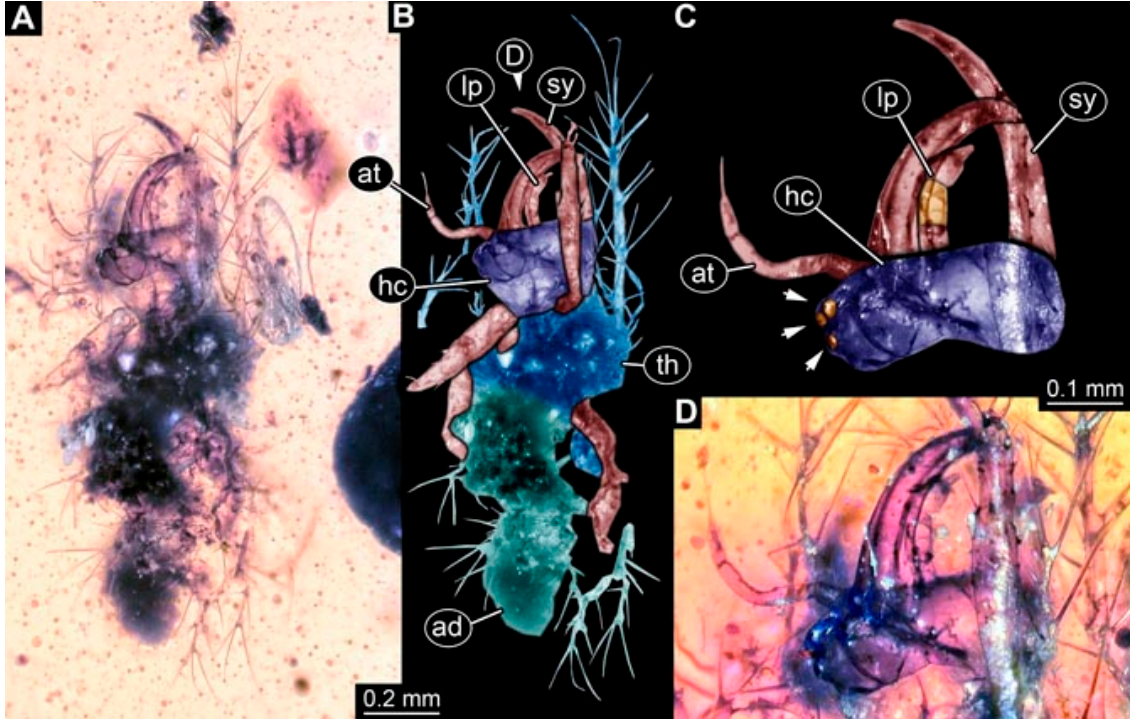
Figure 30. Specimen 4854 (PED 0782); Myanmar amber. ( A ) Dorsal view. ( B ) Dorsal view, colour- marked. ( C ) Close-up of head capsule in dorsal view with stemmata (arrows), colour-marked. ( D ) Close-up of head capsule in dorsal view. Abbreviations: ad = abdomen; at = antenna; hc = head capsule; lp = labial palp; sy = stylet; th = thorax.